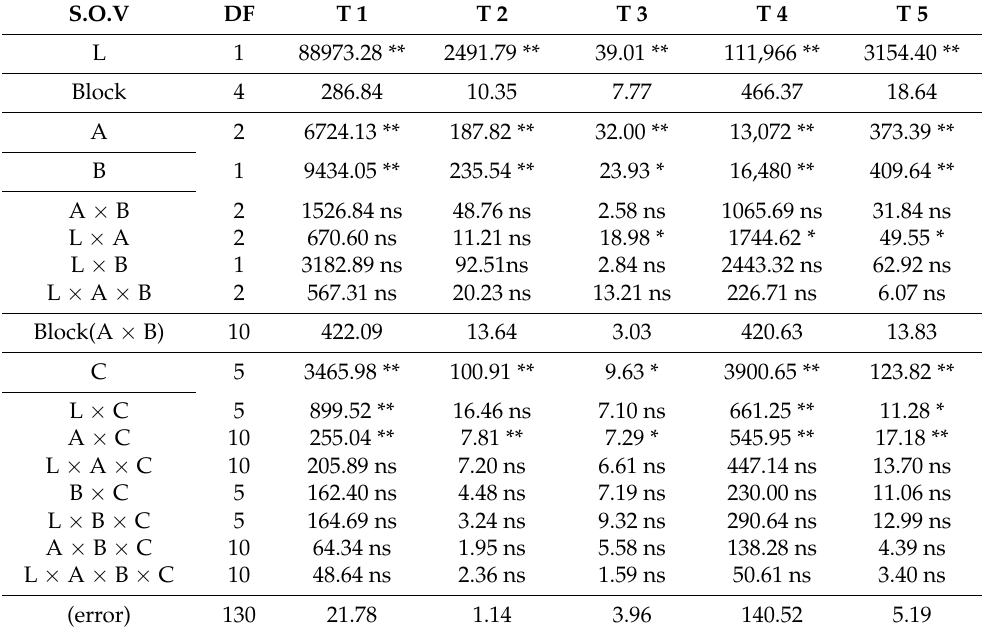
Table 2. Analysis of variance of evaluated quantitative traits. T 1: Root yield (t/ha); T 2: Root dry matter yield (t/ha); T 3: Shoot dry matter yield (t/ha); T 4: Total yield (t/ha); T 5: Total Dry Matter Yield (t/ha); A: Methanol concentration; B: Glycine betaine concentration; C: Genotypes; L: Location; ns (non-significant), * (significant at 0.05), ** (significant at 0.001).